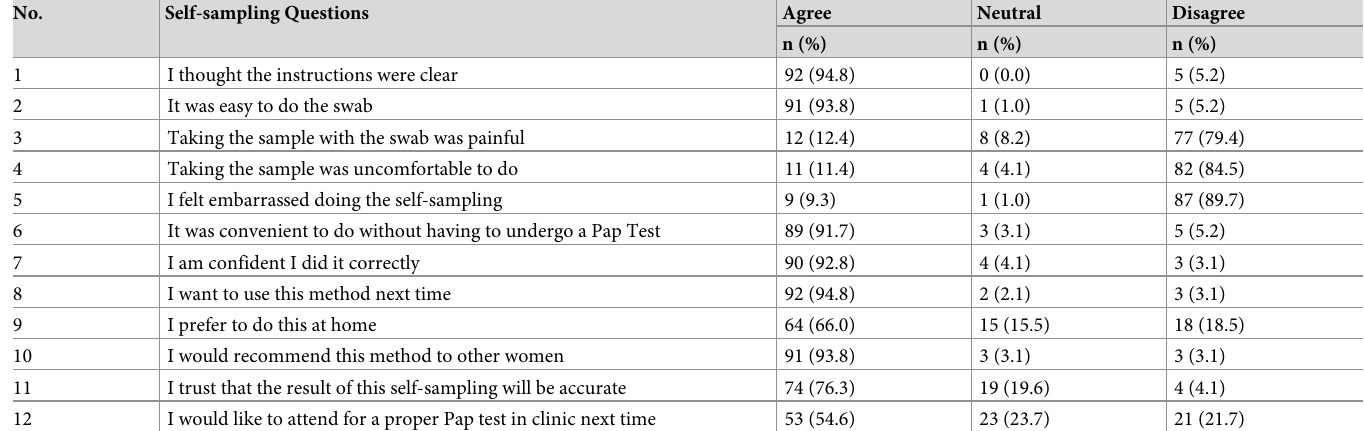
Table 4. Acceptability of HPV self-sampling among non-attendees who participated in HPV self-sampling at JPSHC, Brunei (Jan–Dec 2019). Responses from all Q2 respondents (n = 97) were included.